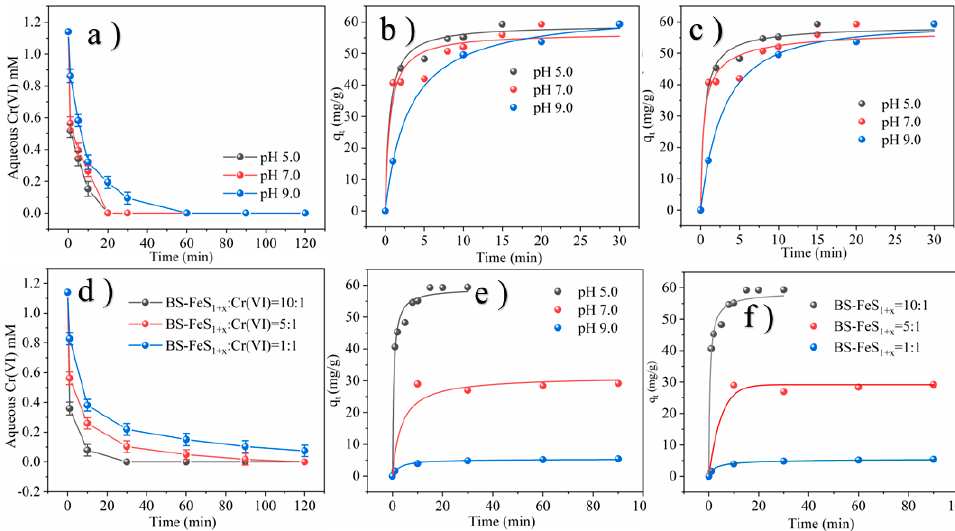
Figure 10. ( a ): Removal effect, ( b ): Pseudo-second-order kinetic fitting of Cr(VI) removal by BS-FeS 1+x under different pH conditions (5.0, 7.0 and 9.0), ( c ): Adsorption kinetic models of Cr(VI) under different pH, ( d ): Removal effect, ( e ): Pseudo-second-order kinetic fitting of Cr(VI) removal under different FeS 1+x :Cr(VI) molar ratios (10:1, 5:1 and 1:1), and ( f ): adsorption kinetic models of Cr(VI) under different molar ratios. Reaction conditions: FeS dosage concentration was 11.4 mM; Cr(VI) dosage concentration was 1.14 mM; initial pH was 5.0; reaction time was 2 h; and speed was 200 rpm. BS-FeS 1+x : biosynthesis of iron sulfides containing SRB. Data were plotted as means of duplicates, and the error bars indicate the standard deviation. Table 5. Kinetic constants for the removal and adsorption of Cr(VI) using biosynthetic FeS 1+x under different pH (5.0, 7.0, 9.0) and FeS:Cr(VI) molar ratios (10:1, 5:1, 1:1).